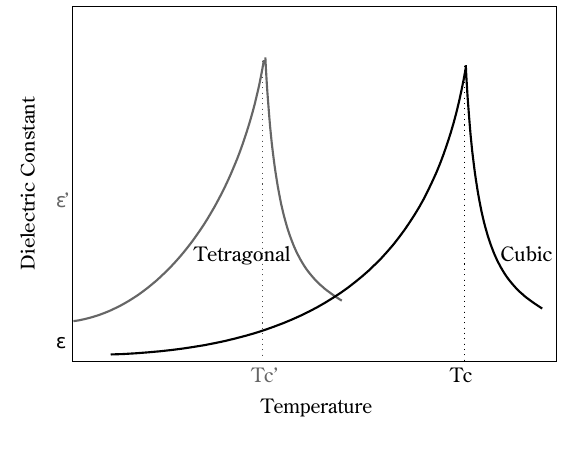
Schematic illustration for the curie temperature shift of BT nanocrystals